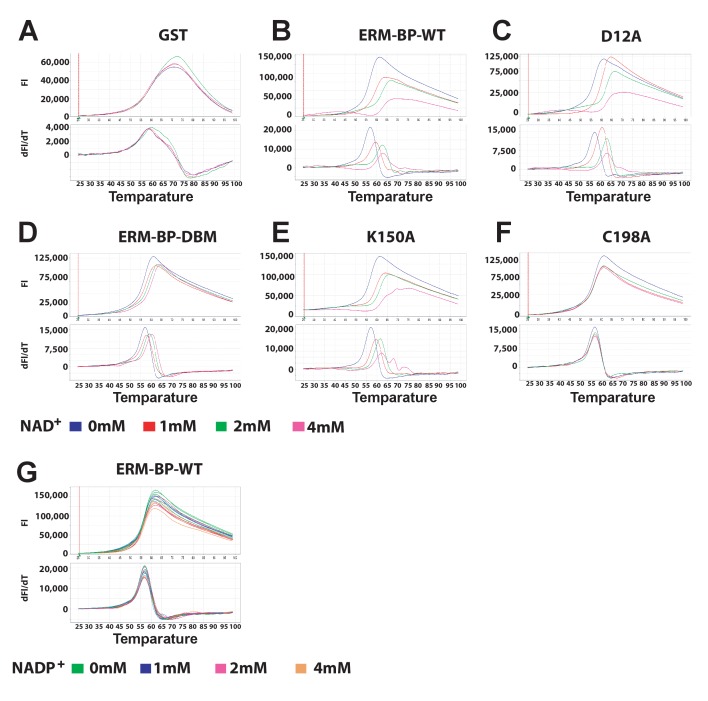
Thermal stability of ERM-BP-WT and mutants in presence of different concentrations of NAD+.The fluorescence intensity (FI) at varying temperatures (upper panel) and derivative melt curves calculated by differences in FI at each temperature (lower panel) are shown. Peak temperature in the lower panel of graph dFl/dT is considered as Tm. The recombinant proteins are (A) GST, (B) ERM-BP-WT, (C) D12A, (D) ERM-BP-DBM, (E) K12A and (F) C198A. Different concentrations of NAD+ were used as indicated as 0 mM (blue), 1 mM (red), 2 mM (green) and 4 mM (pink). Experiments were done in quadruplicate for each NAD+ concentration for each protein and in three independent experiments. Representative thermal shift assay is shown from one experiment. (G) Thermal stability assay of ERM-BP-WT with different amounts of NADP as indicated 0 mM (green), 1 mM (blue), 2 mM (pink) and 4 mM (orange) in quadruplicate for each NADP concentration.